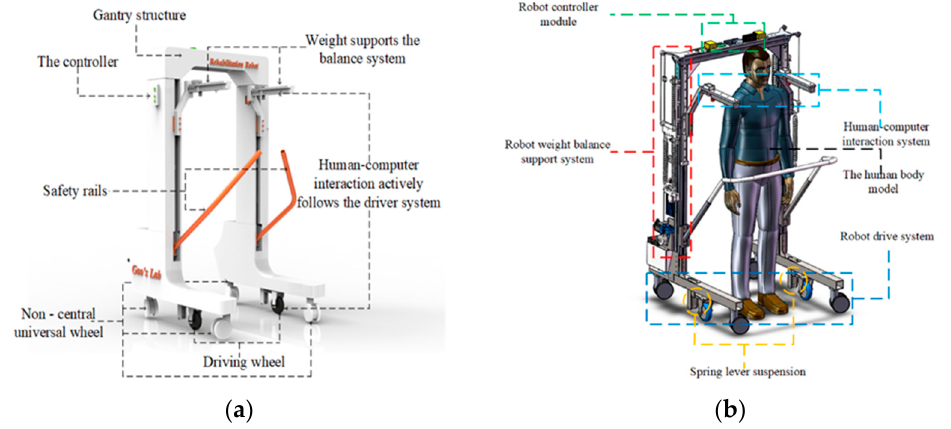
Figure 1. ( a ) Design of rehabilitation robot structure; ( b ) system module of rehabilitation